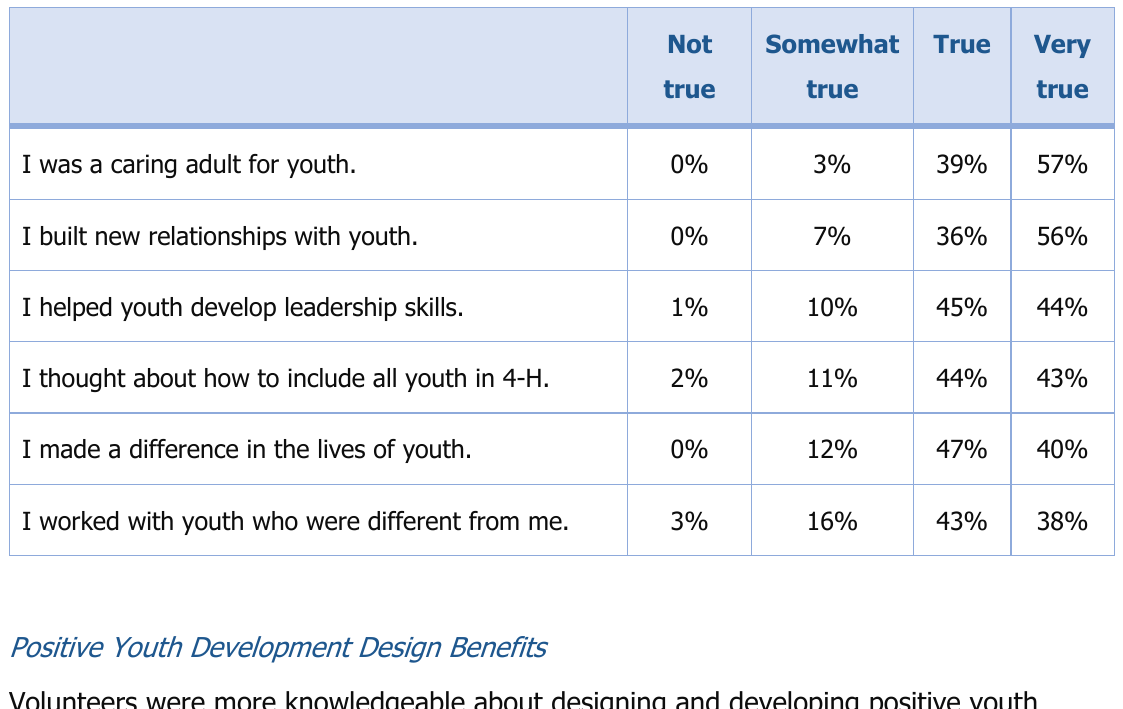
Table 1. Youth Relationship Benefits